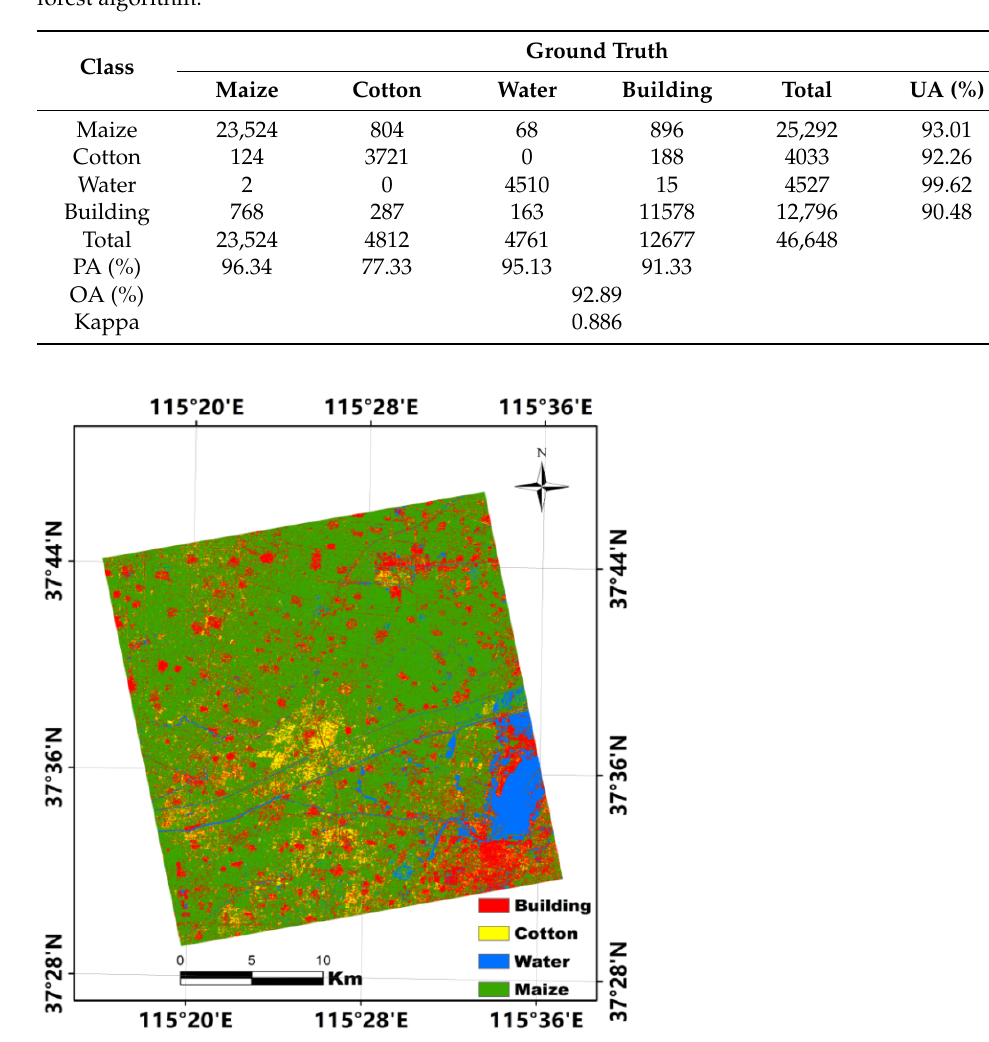
Figure 5. Classification map using 39 features with a single RADARSAT-2 image acquired on 24 September 2018.